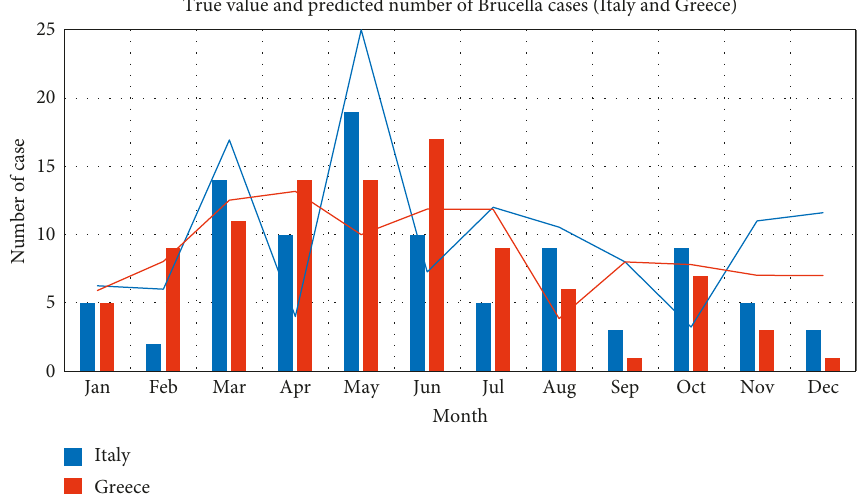
Figure 4: High incidence rate ConvLSTM model monthly forecast results chart (Italy and Greece).